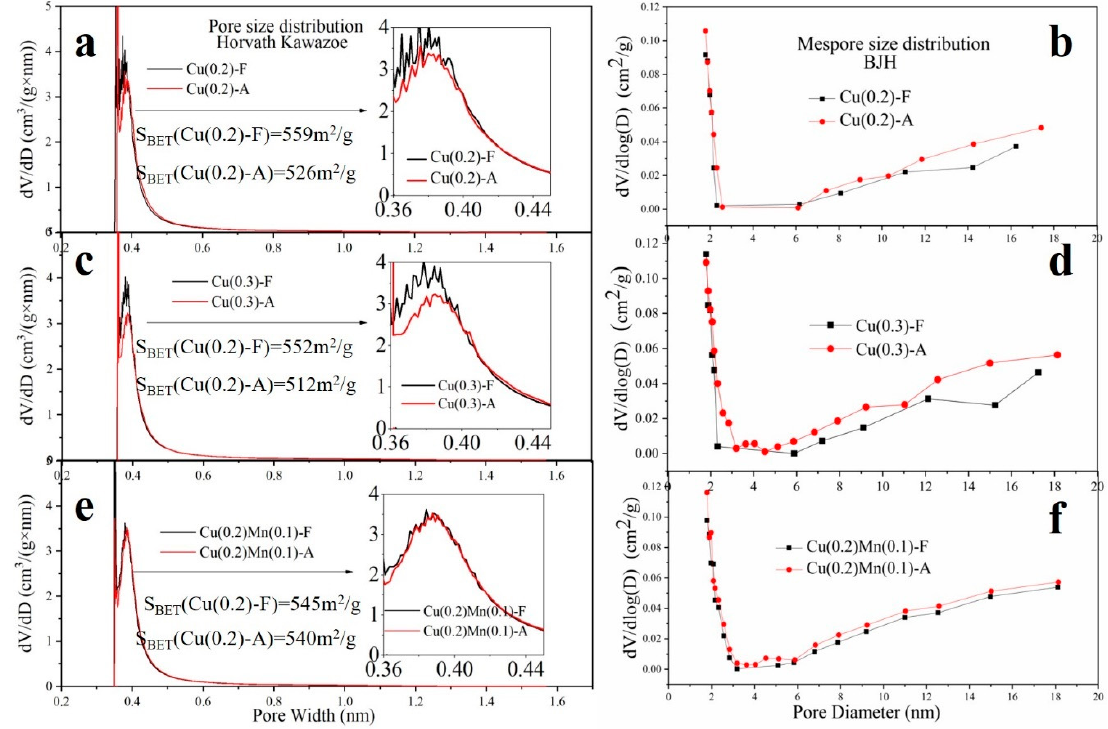
Figure 9. Micropore size distributions of catalysts before and after hydrothermal aging ( a , c , e ) and mesopore size distributions before and after hydrothermal aging ( b , d , f ).